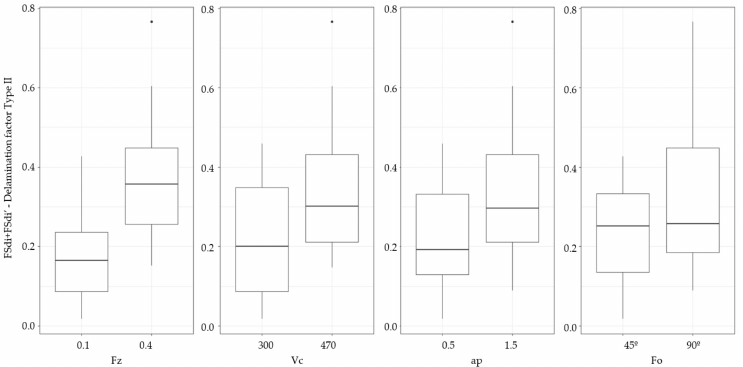
Figure 14. Box-whisker